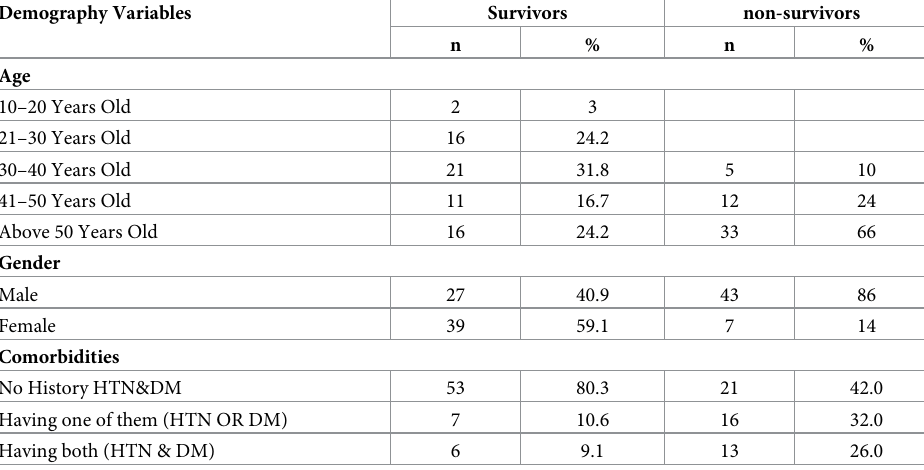
Table 1. Demographic characteristics of COVID-19